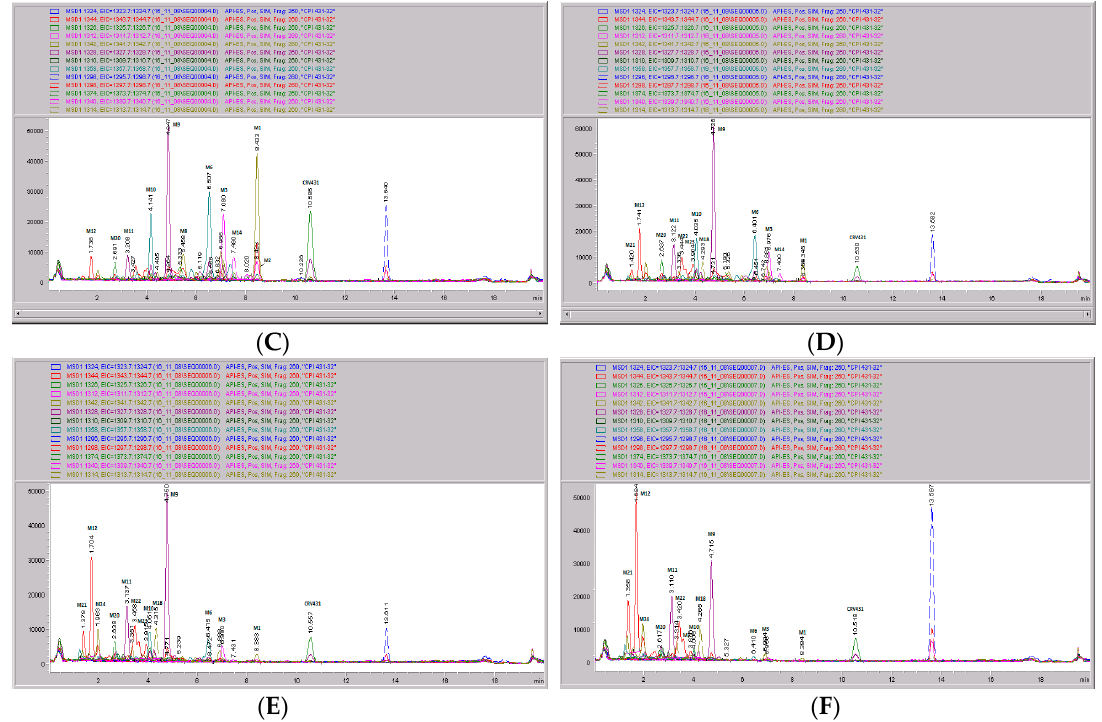
Figure 9. CRV431 metabolism in monkey liver microsomes. Monkey liver microsomes (1 mg/mL) were incubated with 1 ug/mL CRV431, and extracts were removed at 0 (panel ( A ), 5 min (panel ( B )), 10 min (panel ( C ), 20 min (panel ( D ), 40 min (panel ( E ), and 80 min (panel ( F ) for analysis by ESI-LCMS. Each LC-MS profile displays the metabolite abundances as a function of chromatographic retention time. Table 5. Identification of CRV431 metabolites in monkey liver microsomes. Monkey liver microsomes (1 mg/mL) were incubated with 1 ug/mL CRV431, and extracts were removed for analysis by ESI-LCMS. Component